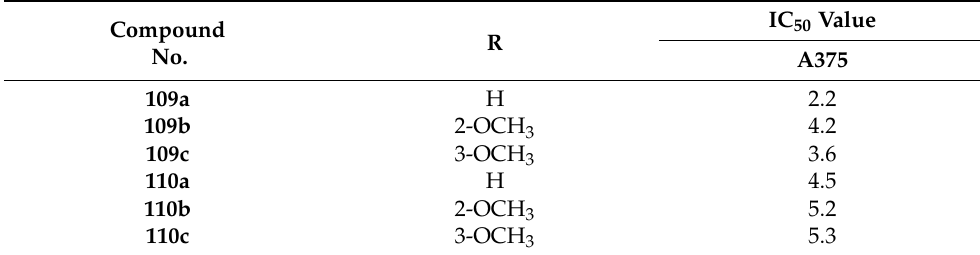
Figure 103. Structure of triazole ‐ pyrrolo ‐ benzodiazepines derivative [ 109 ( a – c ), 110 ( a – c )]. Table 92. In vitro cytotoxic activities of triazole ‐ pyrrolo ‐ benzodiazepines hybrid compounds [ 109 ( a – c ), 110 ( a – c )].